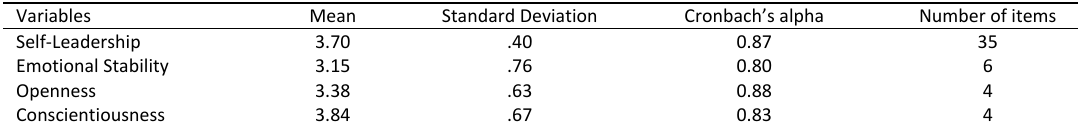
Table 3: Means, Standard Deviations, and Scale Reliabilities Table 3 : Means, Standard Deviations, and Scale